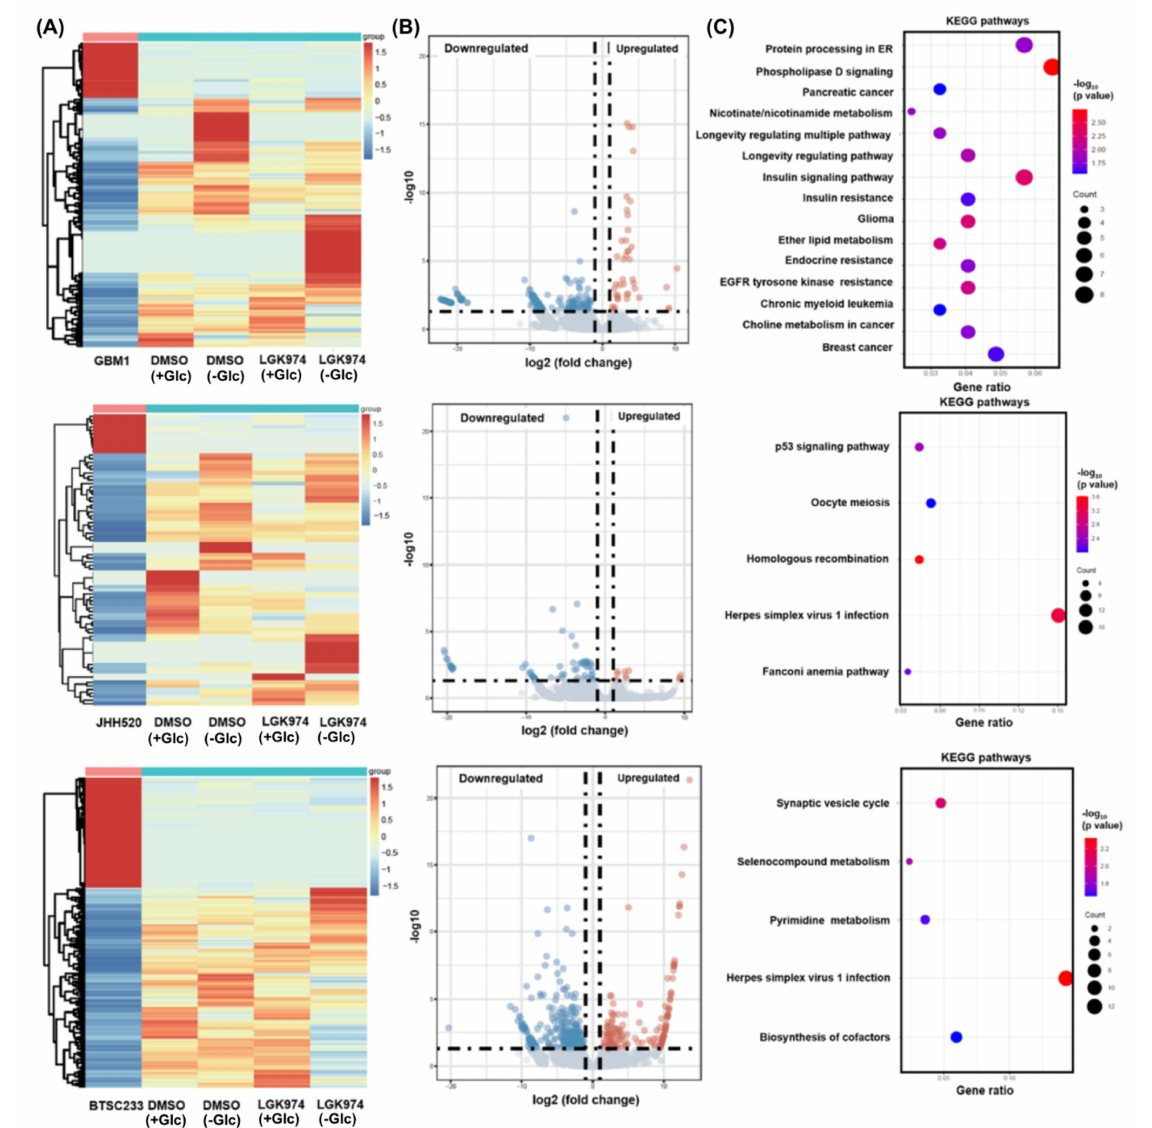
Figure 4. Transcriptome-wide gene expression analysis of GBM1, JHH520, and BTSC233 cells. ( A ) A heatmap showing variations in gene expression in cells treated with DMSO as solvent control and LGK974 in standard cell culture glucose concentration (450 mg/dL) and under com- plete glucose deprivation. ( B ) Altered genes in treated compared to untreated cell lines and ( C ) KEGG-associated